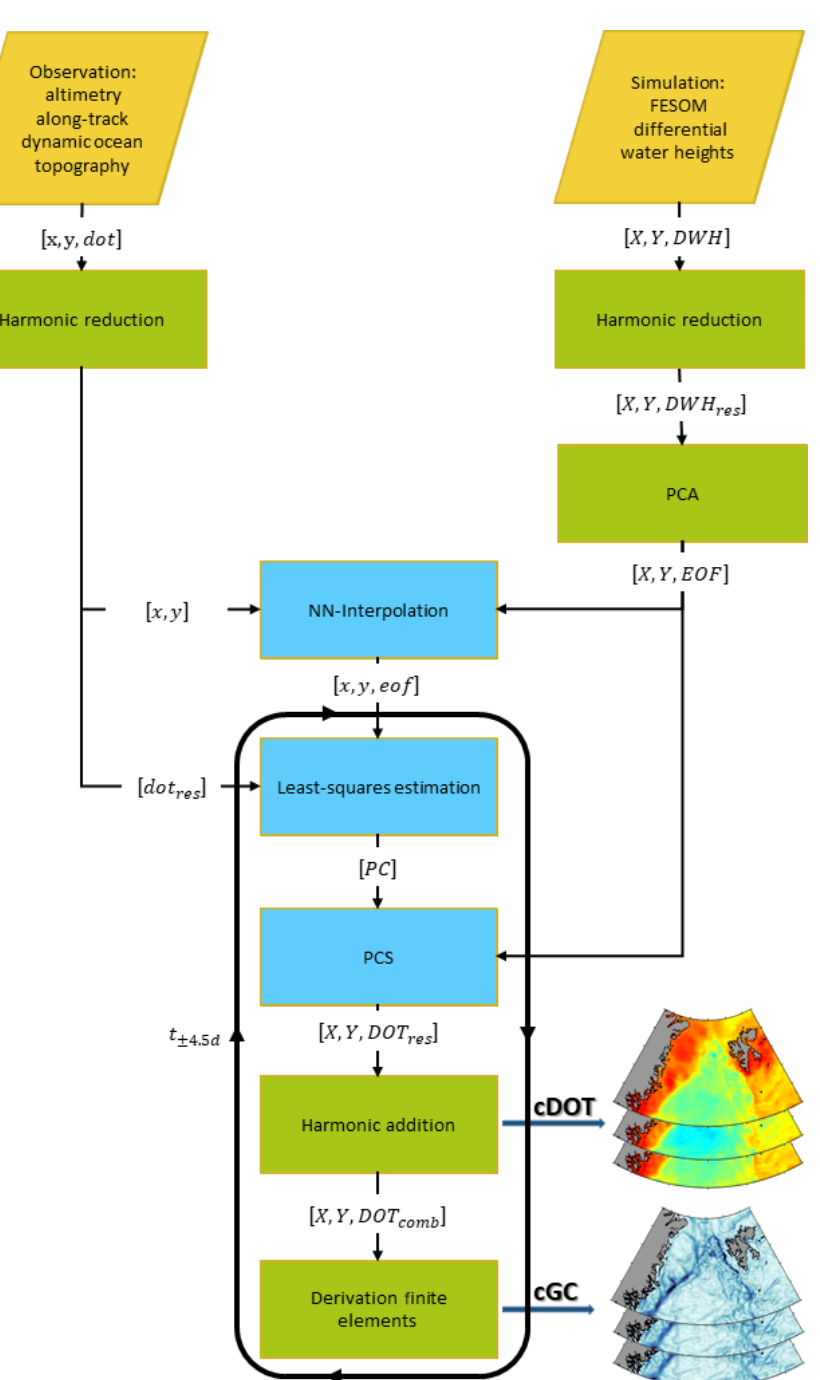
Figure 4. Main processing chain for the generation of combined ocean topography (cDOT) and geostrophic currents (cGCs) showing the main processing steps, i.e., the combination (in light blue) and auxiliary steps (in green). The necessary input data are highlighted in orange. Upper-case coordinates ( X,Y ) are grid coordinates, whereas lower-case coordinates ( x,y ) are on the satellites’ tracks. The same holds for the datasets: data labeled in capital letters are given as a grid, and lower-case letters represent along-track quantities. The “comb” index stands for combined products, and “res” is residual products, reduced by annual signal and constant offset. For dataset abbreviations, see the main